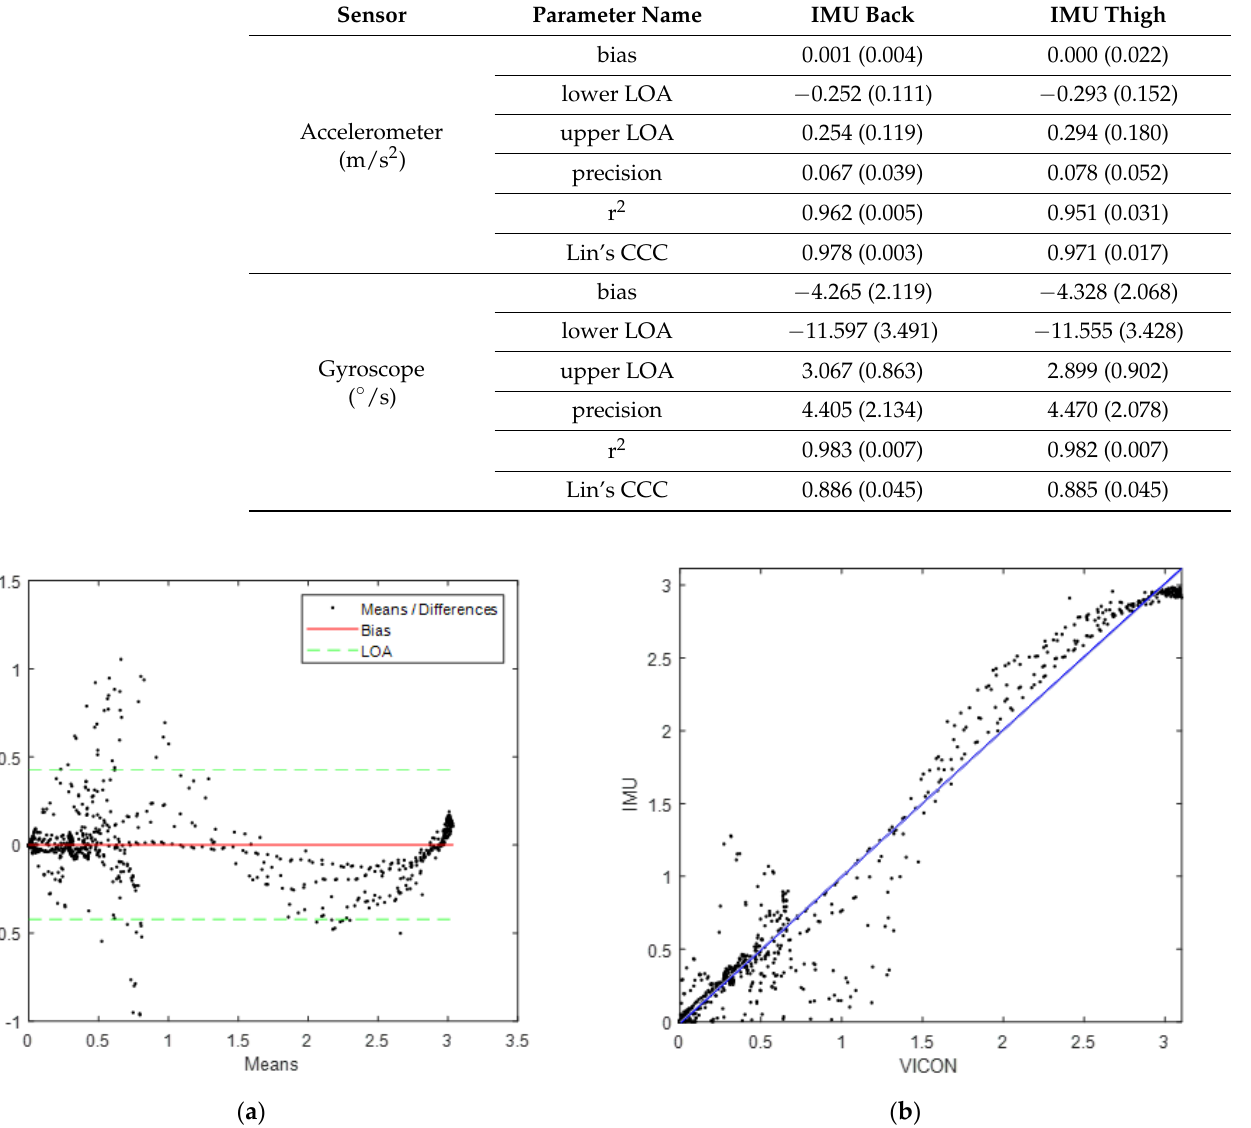
Table 2. Results computed from the Bland–Altman method and Lin’s CCC of sensor validation for all IMUs compared to the reference system (VICON). All values are averaged between acquisition with standard deviation in parentheses.